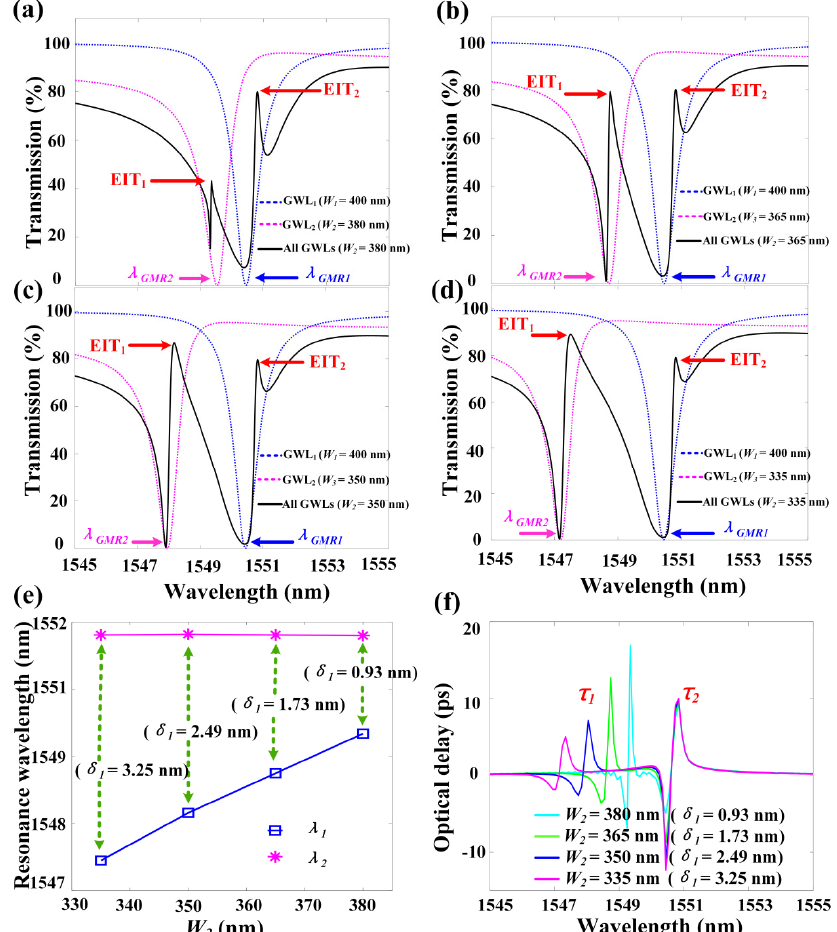
Figure 4. The transmission spectra and delay time under different W 2 (different δ 1 ); other parameters are the same as in Figure 1. ( a ) The transmission spectrum of the system when W 2 = 380 nm ( δ 1 = 0.93 nm); ( b ) The transmission spectrum of the system when W 2 = 365 nm ( δ 1 = 1.73 nm); ( c ) The transmission spectrum of the system when W 2 = 350 nm ( δ 1 = 2.49 nm); ( d ) The transmission spectrum of the system when W 2 = 335 nm ( δ 1 = 3.25 nm); ( e ) Two resonant wavelengths of two EITs under different W 2 (different δ 1 ); ( f ) Two delay times under different W 2 (different δ 1 ).